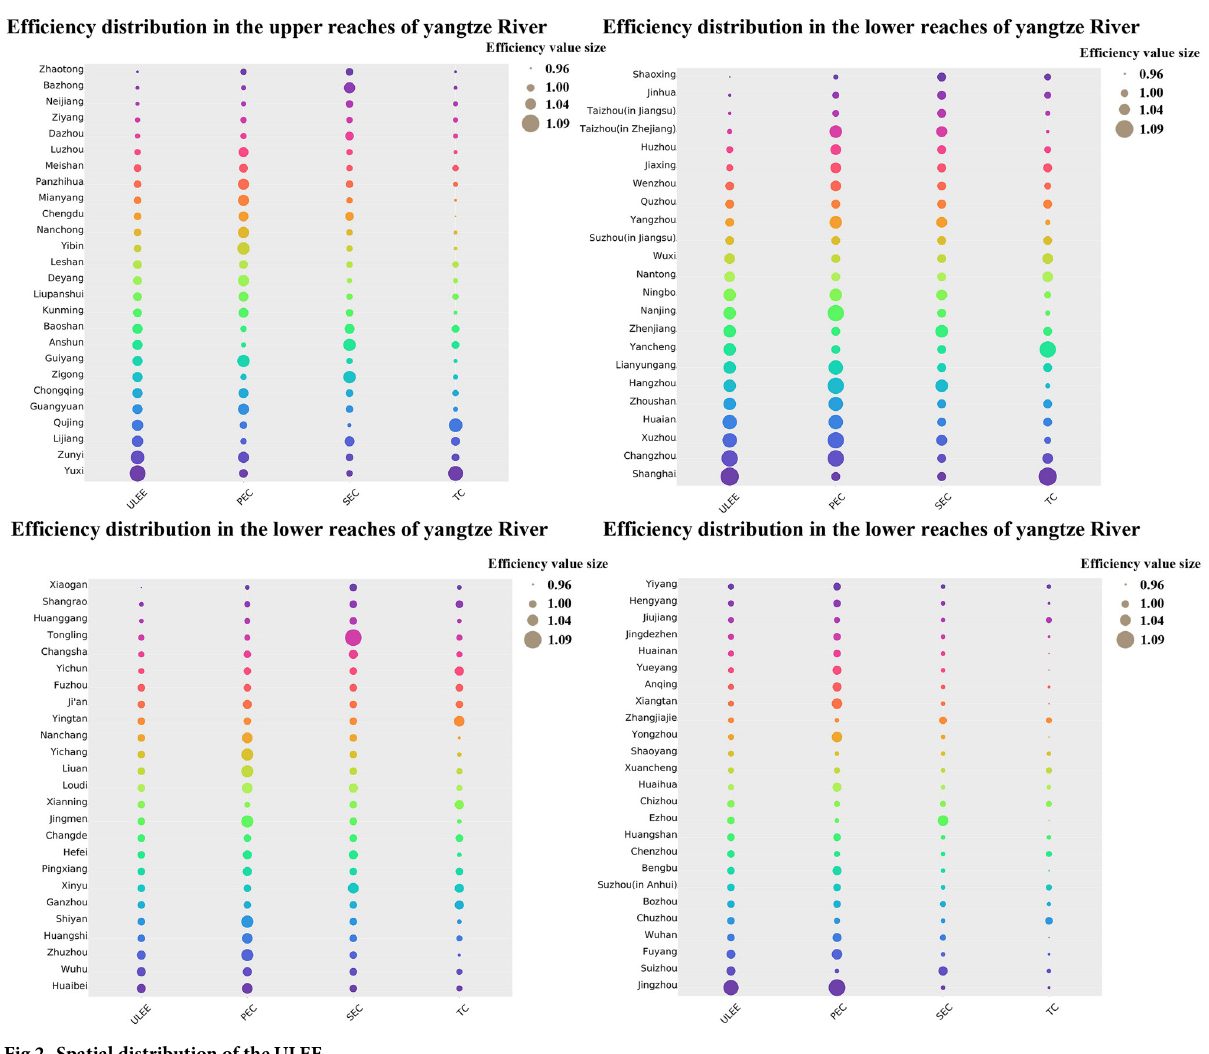
Fig 2. Spatial distribution of the